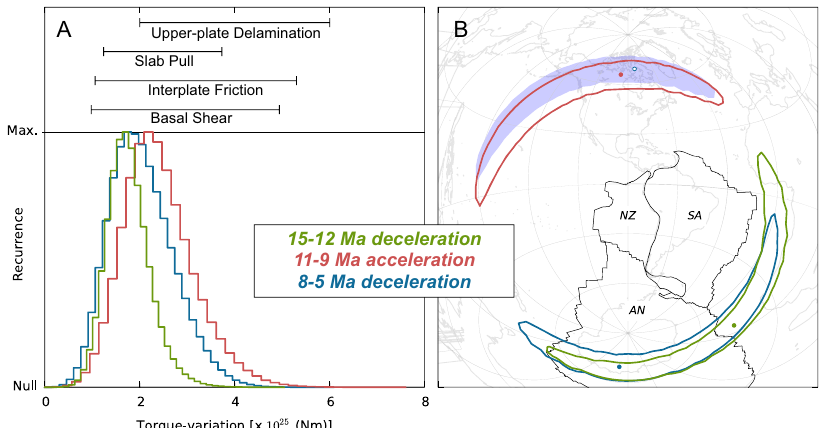
Fig. 5 Torque variations associates to changes in plate convergence between 15 and 5 Ma. A Lower panel shows the statistical distributions of torque- variations upon Nazca plate that are needed to generate the Middle Miocene deceleration (between 15 and 12 Ma in green), main Quechua acceleration (between 11 and 9 Ma in red) and Latest Miocene deceleration (between 8 and 5 Ma in blue). Ensembles of torque variations are calculated from one million samples of the Euler-vector variations. Upper panel shows estimates of torque variations associated with possible geodynamic processes acting on Nazca plate (see main text and Methods). B Map showing the nominal poles of torque-variation (dots) and the contours where 95% of the samples fall, calculated assuming a viscosity of 5E19 Pa*s in the asthenosphere and of 1.5E21 Pa*s in the upper mantle 71 . The light-blue transparent area is the antipodal region of the blue